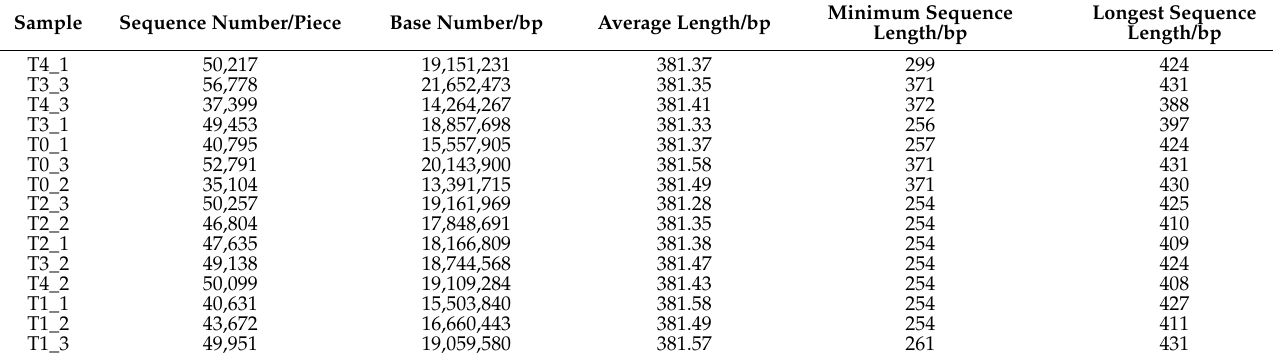
Table 2. Statistics of fungal sample